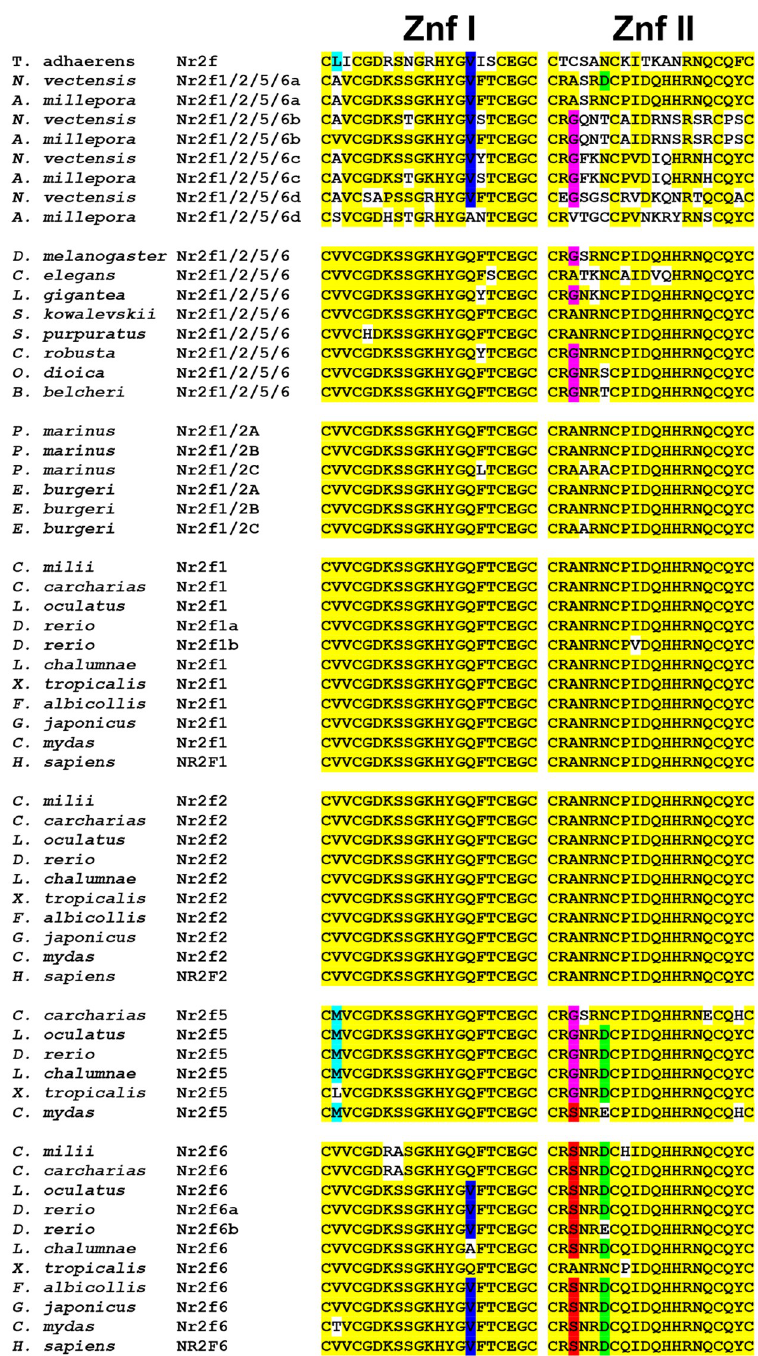
Fig 3. Zinc finger (Znf) motifs within the DBD of the Nr2f family. Alignments of first (I) and second (II) Znfs found in Nr2f TFs. Yellow represents highly conserved amino acids throughout all species. White indicates amino acids that are not conserved. Turquoise and blue indicate amino acid changes that are conserved within Znf I of Nr2f5 and -6, respectively. The valine change found in some Nr2f6 LBDs is also found in the placozoan and cnidaria Nr2fs. Magenta and red indicate amino acid changes at the same residue that are conserved within Znf II of Nr2f5 and Nr2f6, respectively. A glycine residue is also found at the same position in some cnidaria and invertebrate Nr2fs. Green indicates a conserved change found in most Nr2f5 and Nr2f6 Znf